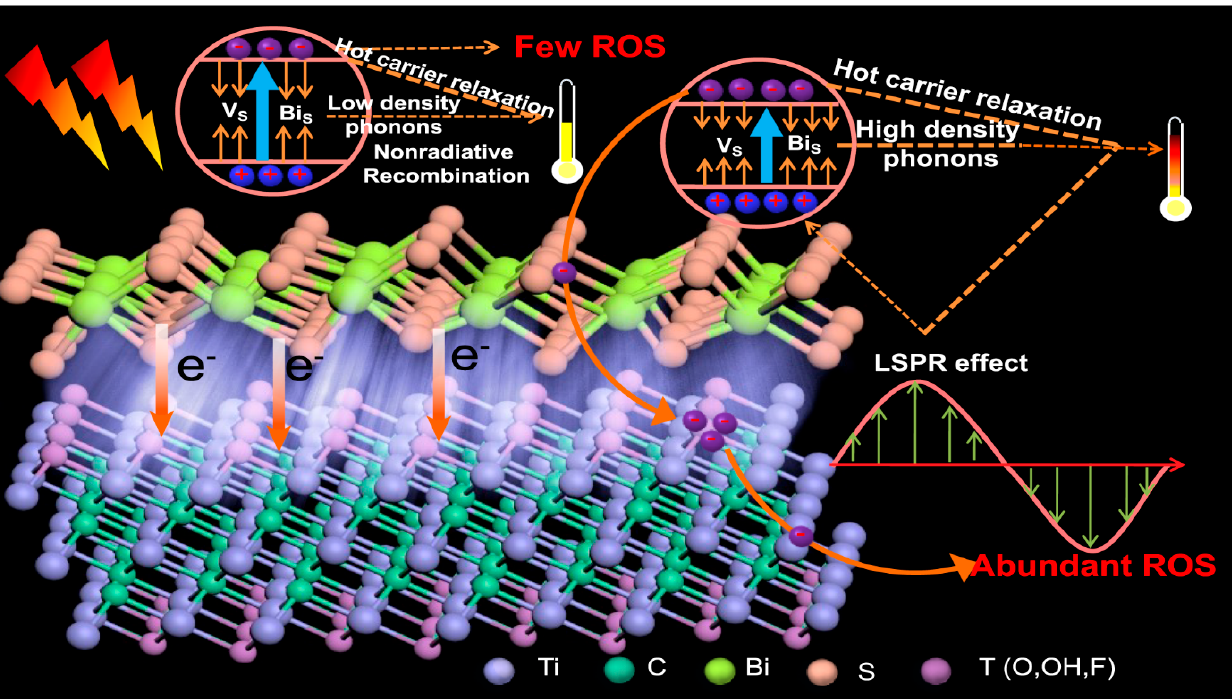
Figure 7. A schematic illustration of the photo-thermal mechanism of Bi 2 S 3 and Ti 3 C 2 T x . The data was reproduced with permission [90] .